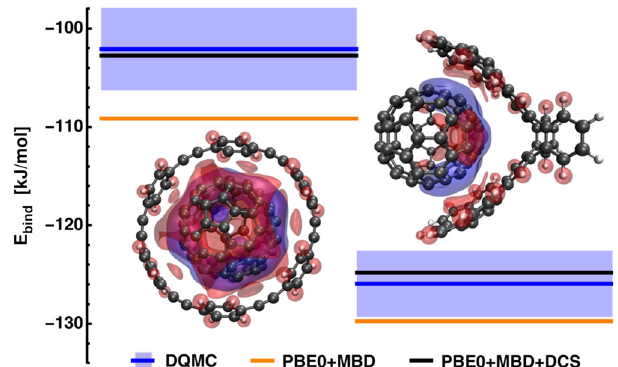
Fig. 2 Binding energies and dispersion – polarization of a C 70 fullerene different host molecules. Host molecules: 6-CPPA (left), “ buckyball- catcher ” (right). PBE0 + MBD results (orange), diffusion quantum Monte- Carlo reference (DQMC, blue line; error bars shown as boxes), PBE0 + MBD including dipole-correlated Coulomb singles (DCS, black line). DQMC reference data were taken from ref. 16 . The depiction of the complexes includes iso-surfaces at ±0.003 (a.u.) of the change in the density of electronic fl uctuations with respect to the isolated monomers (red: decrease, blue: